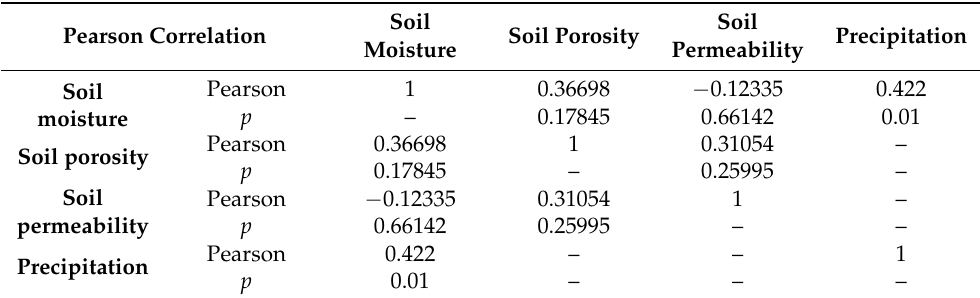
Table 3. Analysis of correlation.